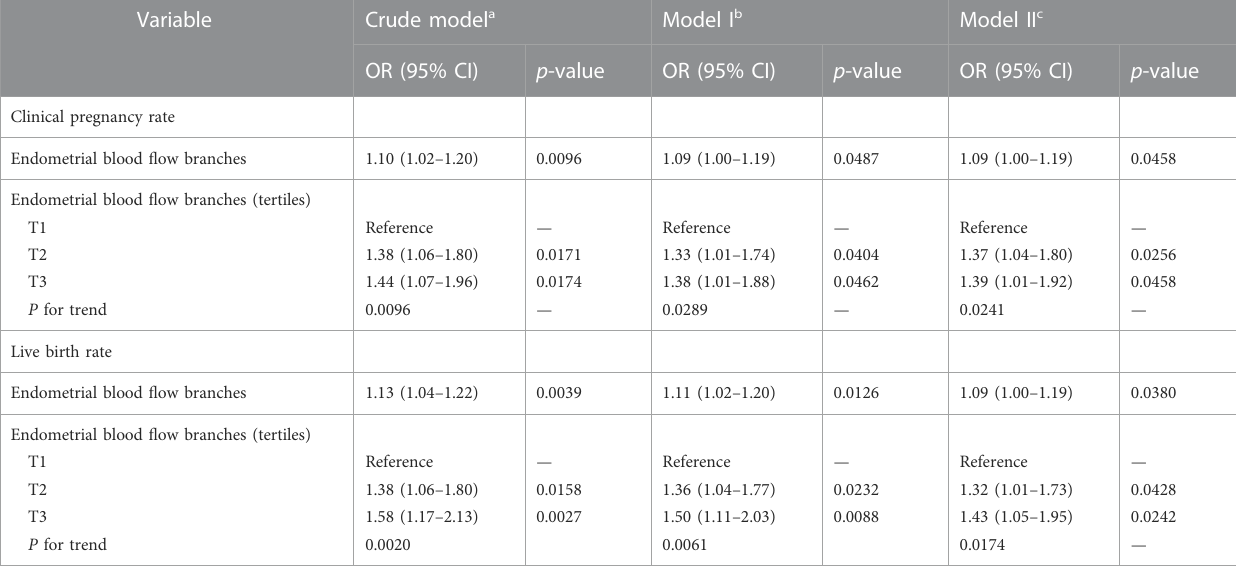
TABLE 3 Multivariable analysis to assess the independent impact of endometrial blood fl ow branches on clinical pregnancy